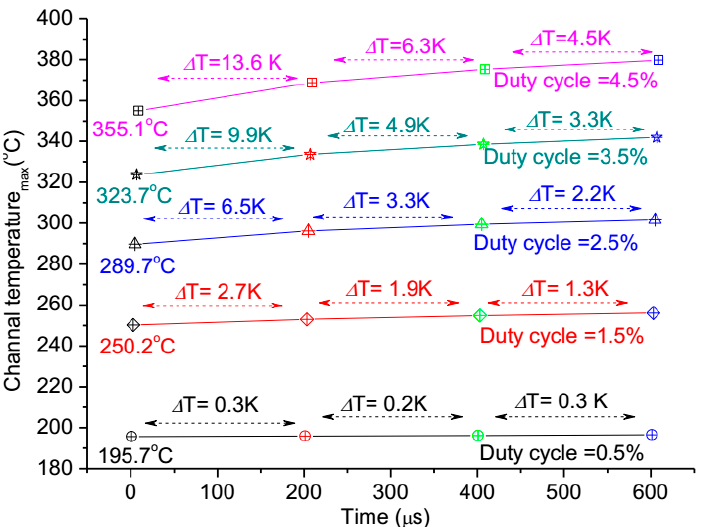
Figure 5. The impact of pulse width on maximal channel temperature during four pulse repetition periods.